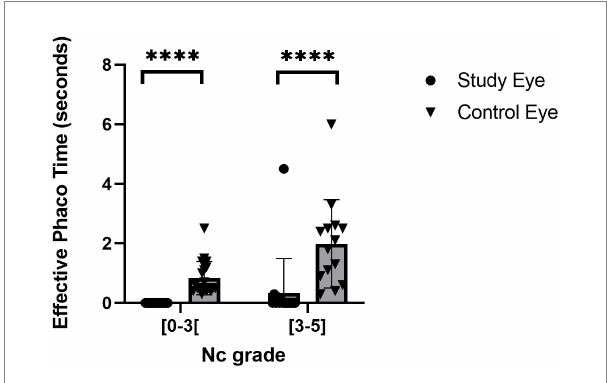
FIGURE 5 Effective phaco time according to the nuclear color cataract